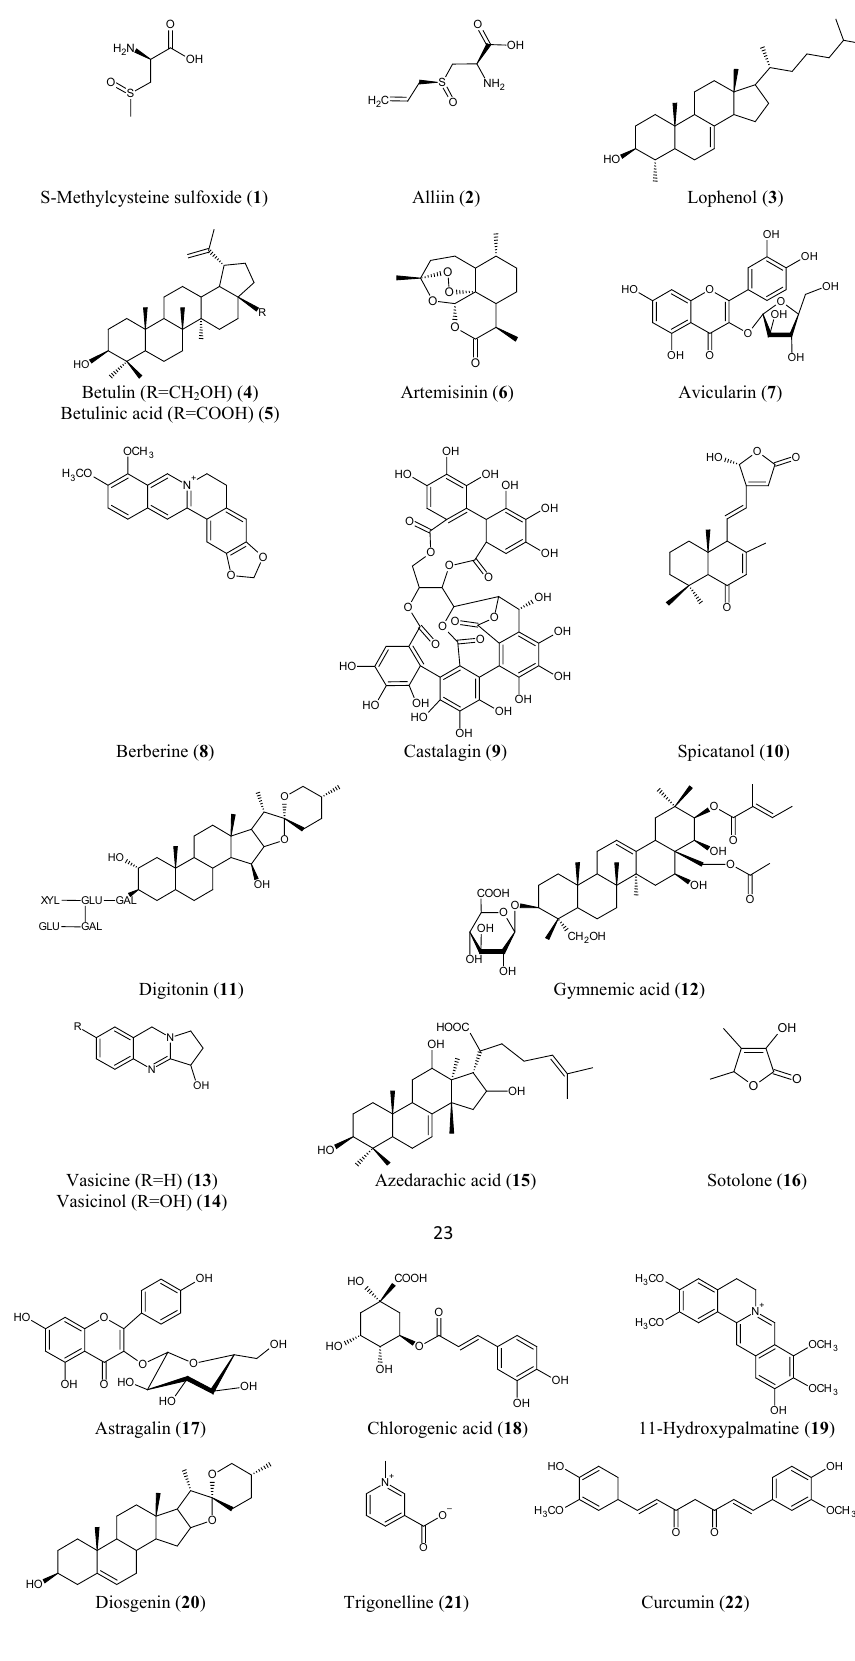
Fig. 2 Selected antidiabetic compounds reported from surveyed